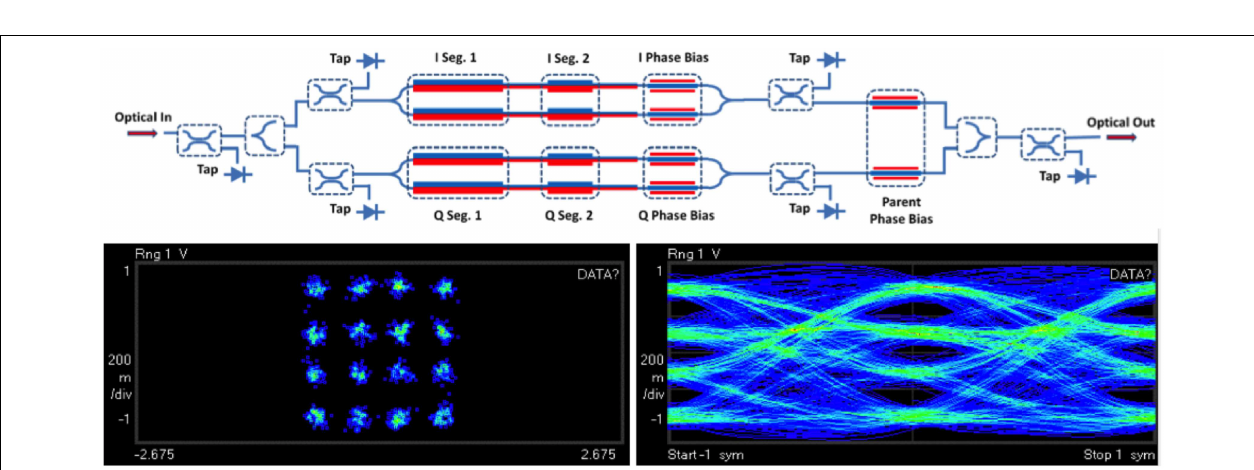
FIGURE 23 | 2-bit optical DAC in silicon